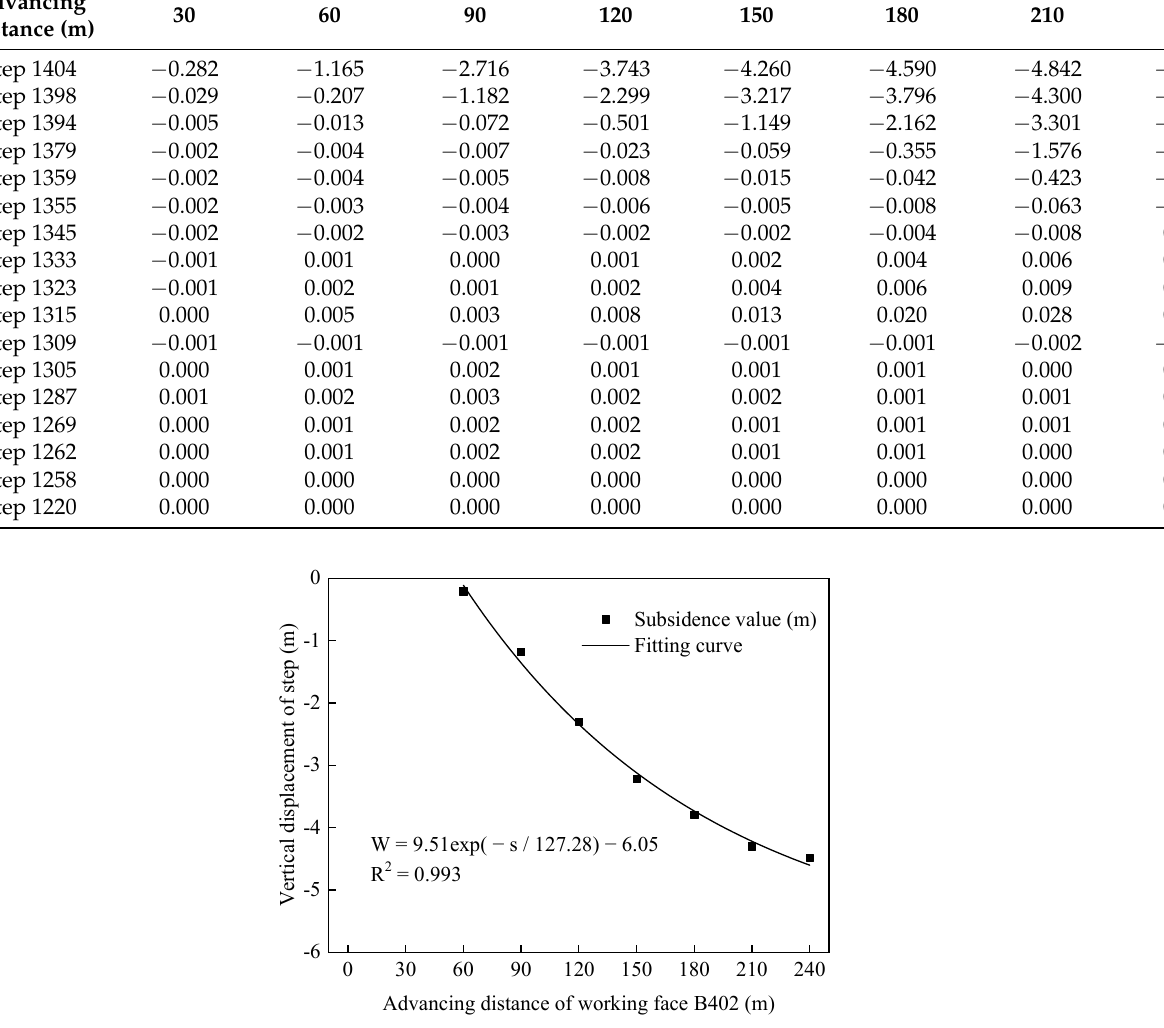
Figure 9. Vertical displacement changing law of Step 1398 during working face advancement.